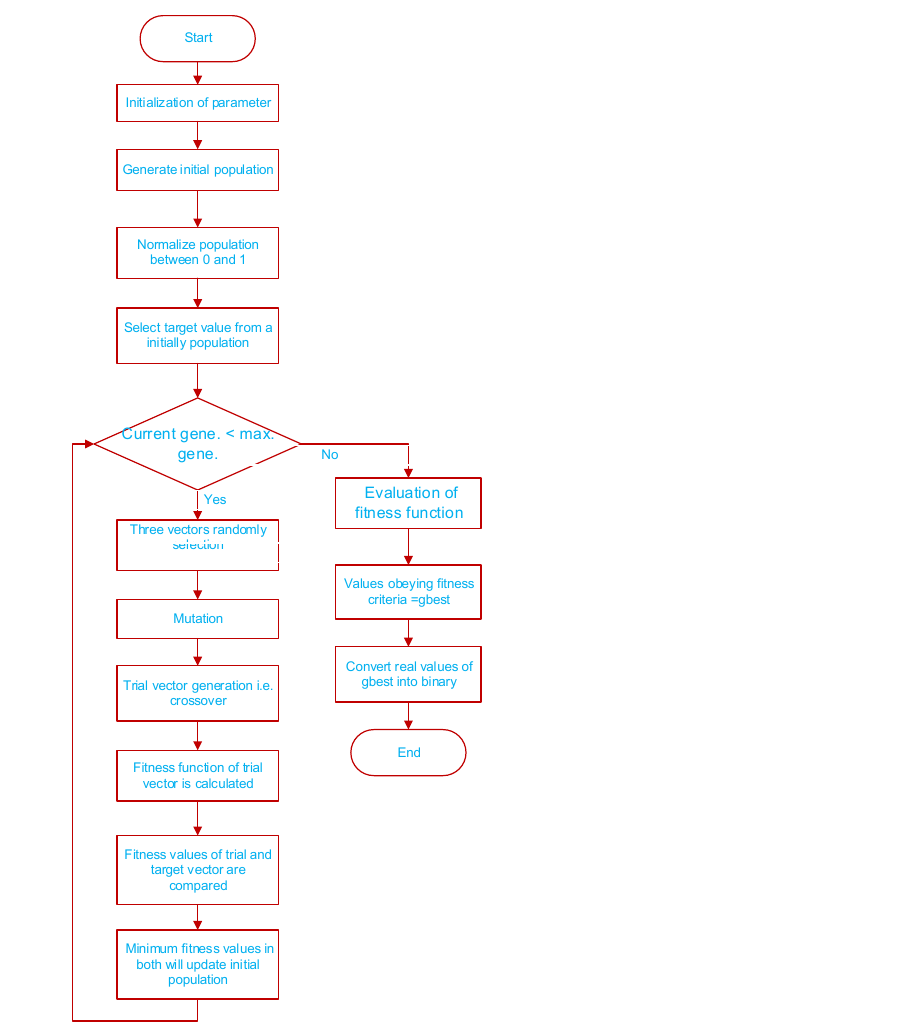
Figure 5. DE implementation